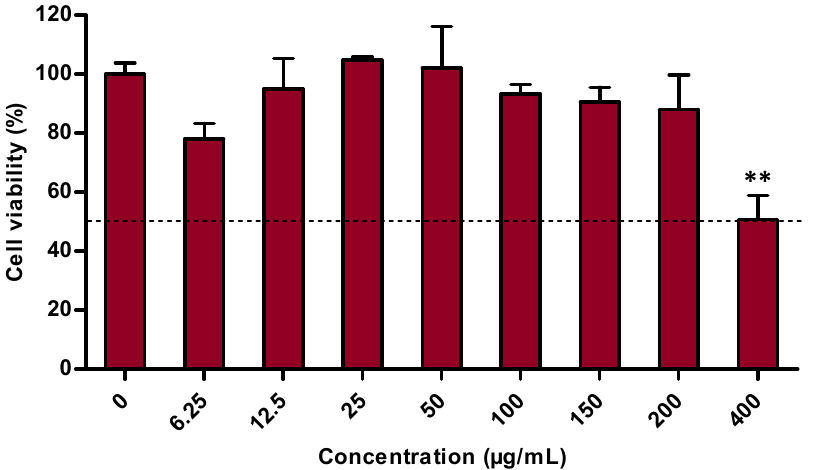
Figure 1. Cytotoxicity assessment of the K. angustifolia extract on primary human keratinocytes performed by measuring metabolic activity with a MTT assay. All the experiments were carried out in at least triplicate and presented results are representative of at least two different experiments ( N = 2, n = 3). Data are presented as means of the triplicates ± S.D. The horizontal line is set at 50% cell viability. Statistical significance was determined using a one-way ANOVA followed by a Dunnett’s post hoc test ( p -value < 0.05 compared to control), ** p -value <